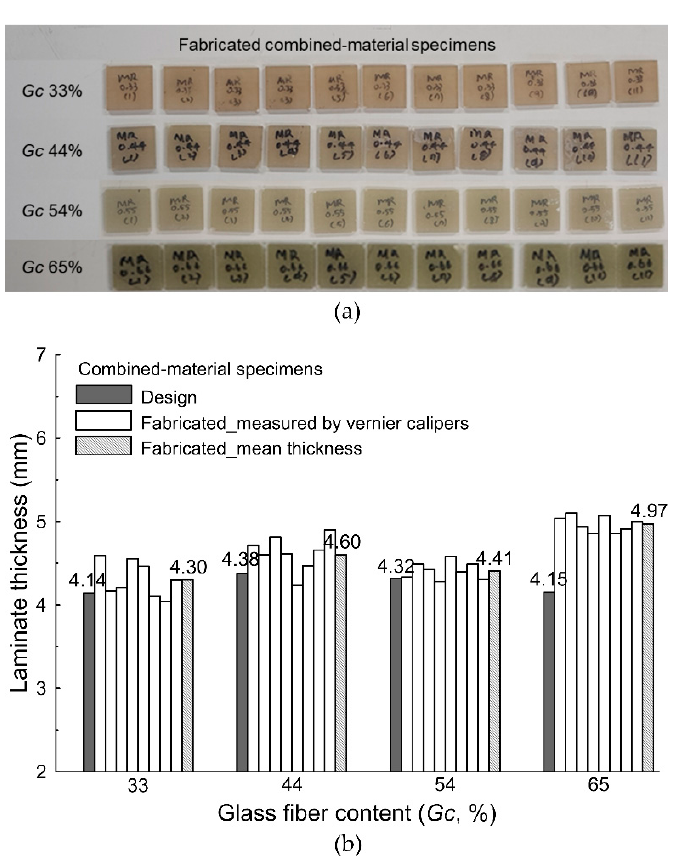
Figure 6. Combined-material specimens: ( a ) produced specimens; ( b ) measured thickness.